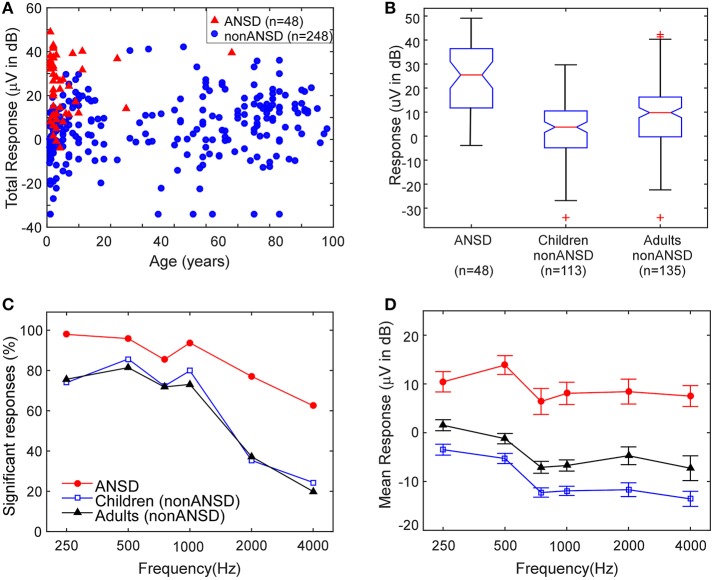
RW ECochG-TR for all CI ears. (A) Scatter plot of ECochG-TR vs. Age. (B) Distributions of ECochG-TR for three groups. (C) Percent of cases with significant responses across frequency for the three groups. (D) Magnitude of significant responses across frequency for the three groups.